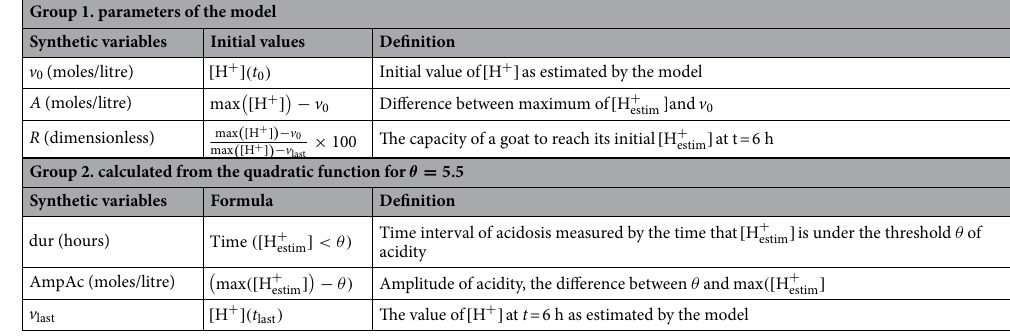
where, d i → i + 1 stands for the daily score assigned to the daily response of a goat, and GI is the global index for each goat. Statistical analysis. Software R version 3.5.3 (R core team 2019; https ://www.R-proje ct.org/) 30 was used for all statistical analyses. For correlation analysis, because the distribution of synthetic variables was not Gaussian, the Spearman correlation test was used. To study the effect of fixed variables of the model, the likelihood ratio test (ANOVA function in R) was used. When significant effects of weeks were found, a post hoc comparison test with FDR correction was applied (emeans package 31 ). The function nls of package stat was used to estimate the parameters of the quadratic function (Model 1.2). For each of the synthetic variables, the Gaussian distribution was checked with a Shapiro–Wilk test 32 . In the absence of normality, a box-cox transformation was applied to determine the adequate power transformation, using the boxcox function of R. Finally, the function lme4 was used for the mixed models 33 .